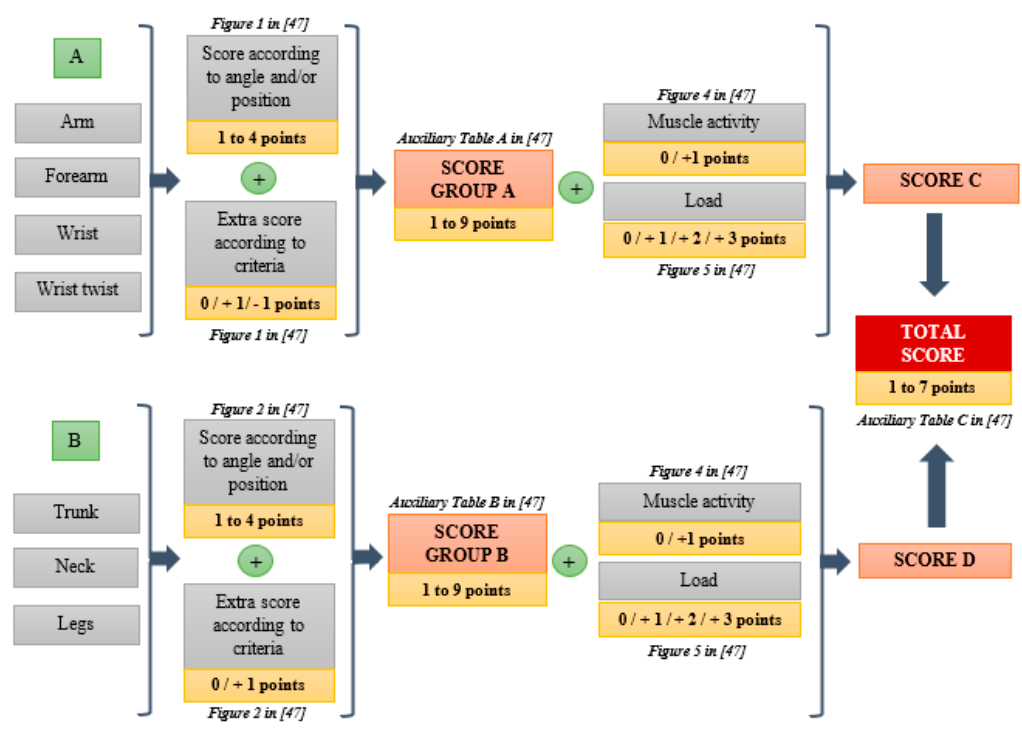
Figure 4. Calculation process in RULA (Rapid Upper Limb Assessment) method (adapted from [47,51]). Table 2. RULA action levels (adapted from [47,51]).